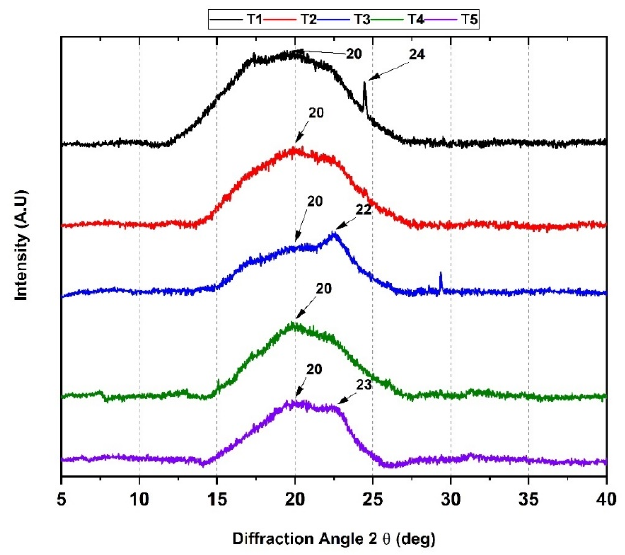
Figure 5. XRD diffraction pattern of the five composites, according to Table 1. T1 (100%CS); T2 (25%G:75%CS); T3 (50%G:50%CS); T4 (75%G:25%CS); T5 (100%G).